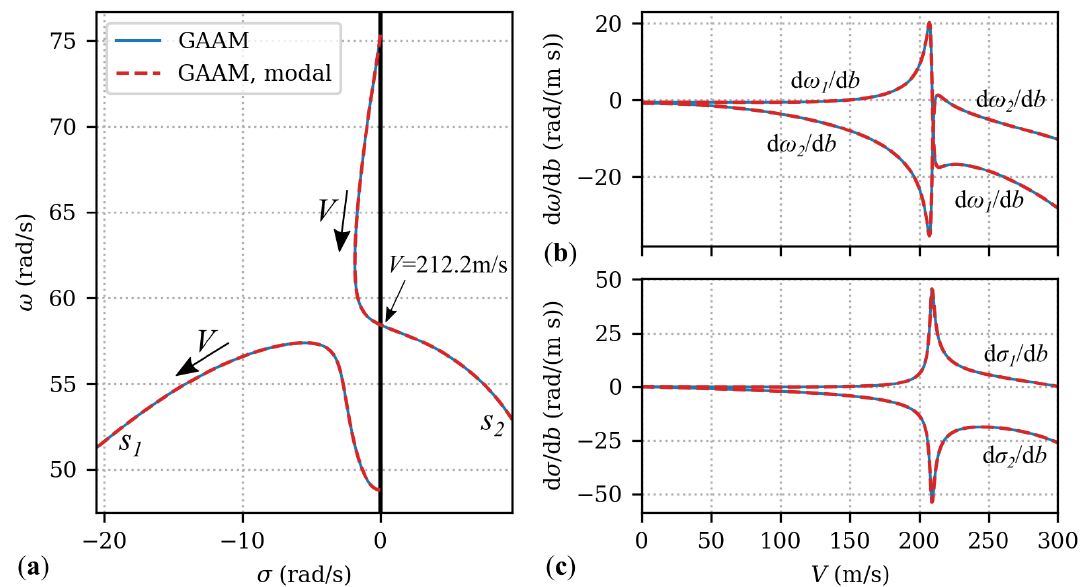
Figure 5. Comparison of eigenvalue solutions and eigenvalue derivatives in physical and modal coor- dinates for GAAM. ( a ) Eigenvalues in the complex plane. ( b ) Real part of the eigenvalue derivatives over freestream velocity. ( c ) Imaginary part of the eigenvalue derivatives over freestream